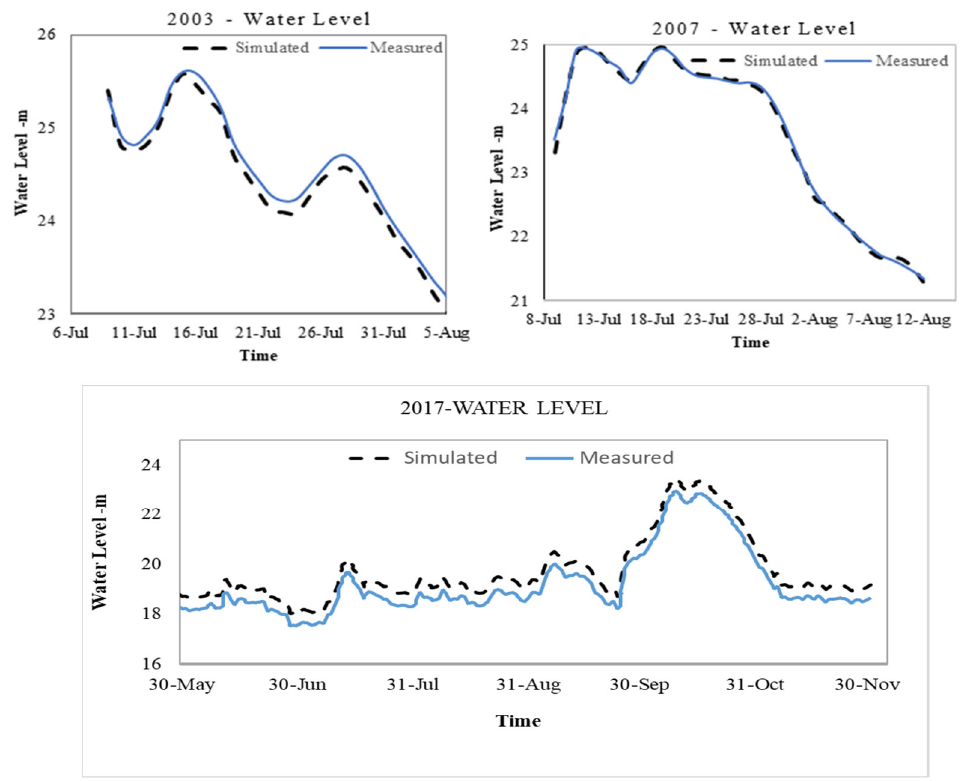
Figure 2. Comparison of simulated and measured water levels in 2003, 2007, and 2017 at Xiashankou hydro station. The blue and black line represent the water level at a certain point where measured water level (blue line) and simulated water level (dash blackline).